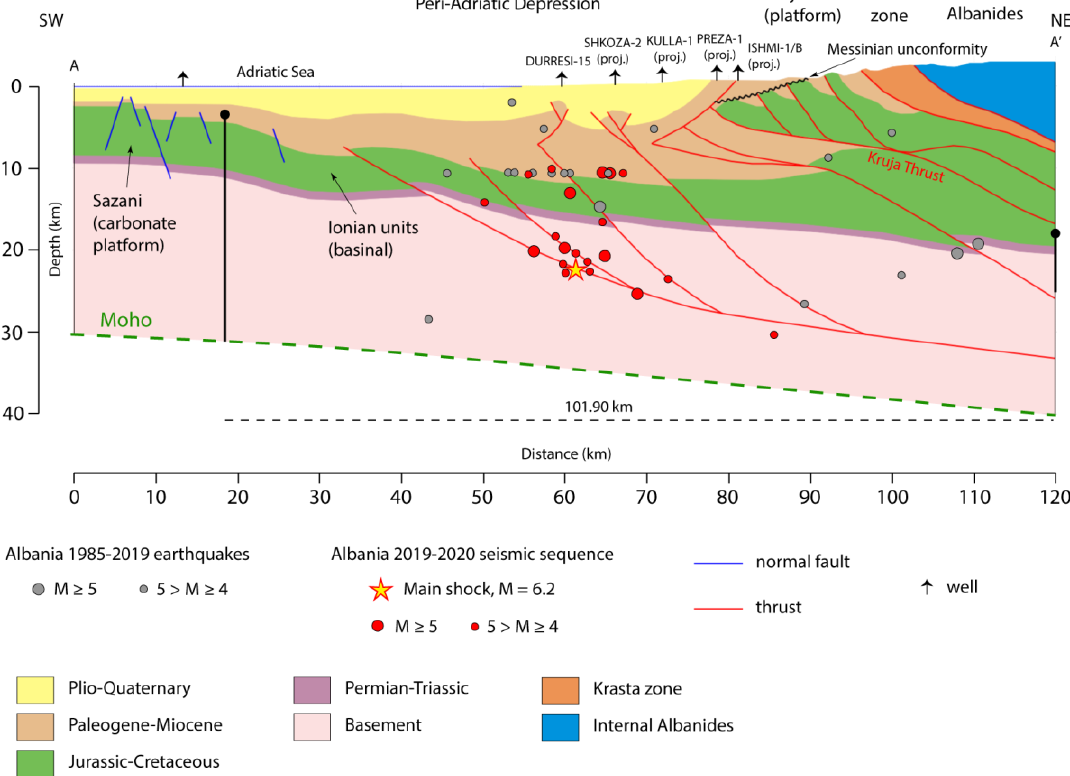
Figure 4. Geological cross-section of 120 km across outer Albanides (A-A’ segment on Figures 1 and 2). The sedimentary cover structure is based on Frasheri et al. [6], Roure et al. [10] and Muceku et al. [12] (modified). The Moho is based on Grad and Tiire [34]. The section shows an earthquakes’ hypocenter (some earthquakes clustering at a 10 km depth is an automatic location). No internal stratigraphy is shown for the Internal Albanides and Krasta zone. Pin lines used for cross-section restoration are shown.